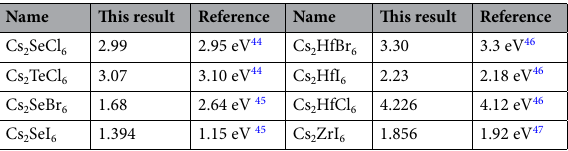
Table 1. Some known band gap reference values of perovskite crystals.